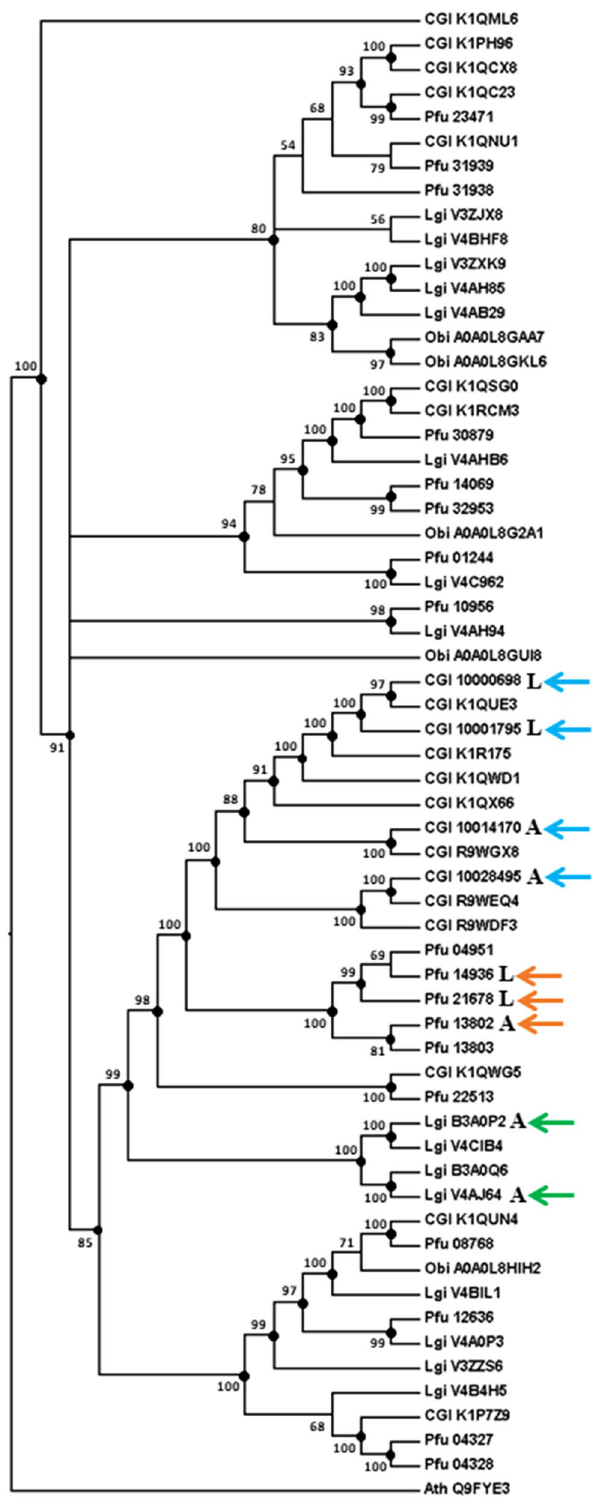
Figure 5. Bayesian phylogenetic analysis based on 935 amino acid residues of CA domains in molluscs. SMPs are indicated by blue ( C. gigas ), orange ( P. fucata ) and green ( L. gigantea ) arrowheads. Polychotomy is generated if the posterior probability of the node is < 50. Posterior probabilities are shown if ≥ 50, and marked with black dots if ≥ 80. Cgi, Crassostrea gigas ; Pfu, Pinctada fucata ; Lgi, Lottia gigantea ; Obi , Octopus bimaculoides. Ath, Arabidopsis thaliana